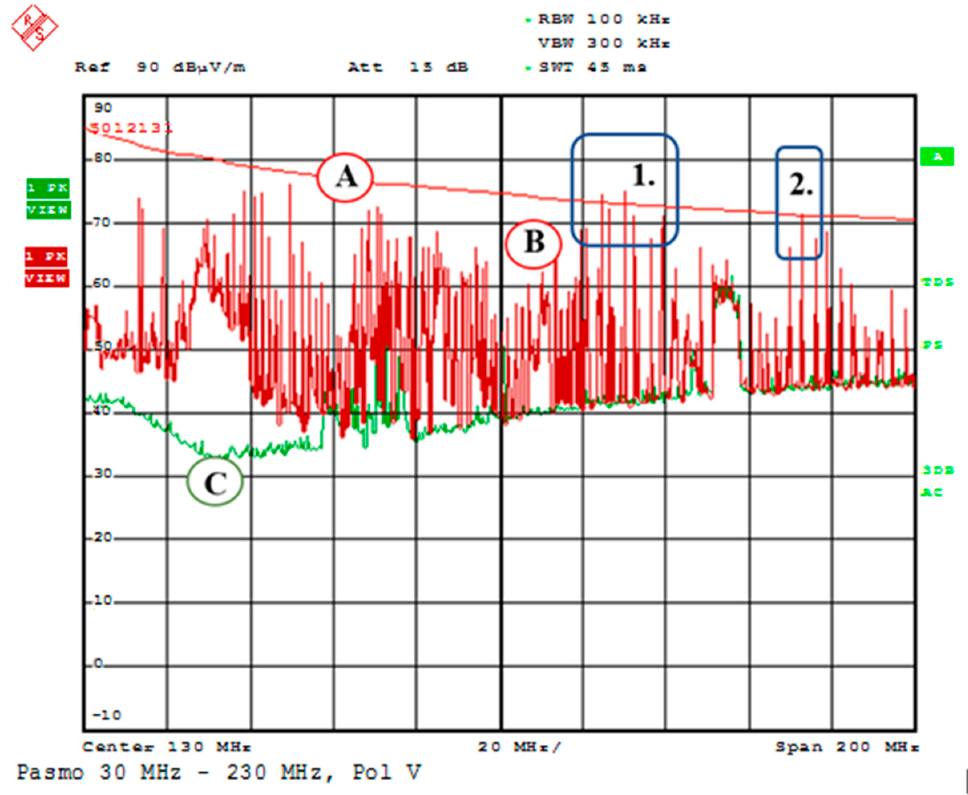
Figure 12. Spectrum of interfering signals radiated by a rail vehicle travelling at a speed of 50 km/h and the electromagnetic background for a frequency range of 30 MHz–230 MHz.